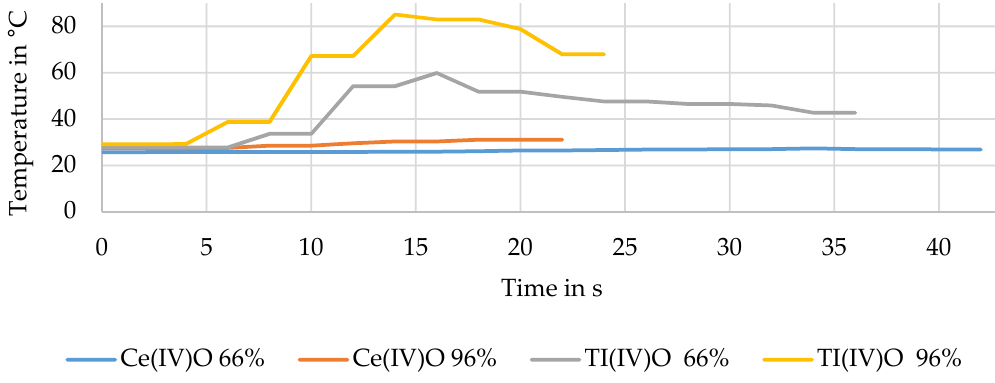
Figure 12. Temperature development underneath a UV radiator during the process.